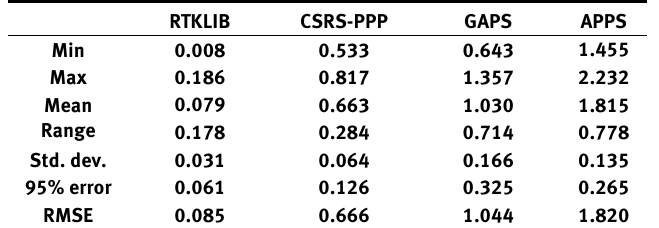
Table 7. Results for 2D displacements (Pix4Dmapper) (m).